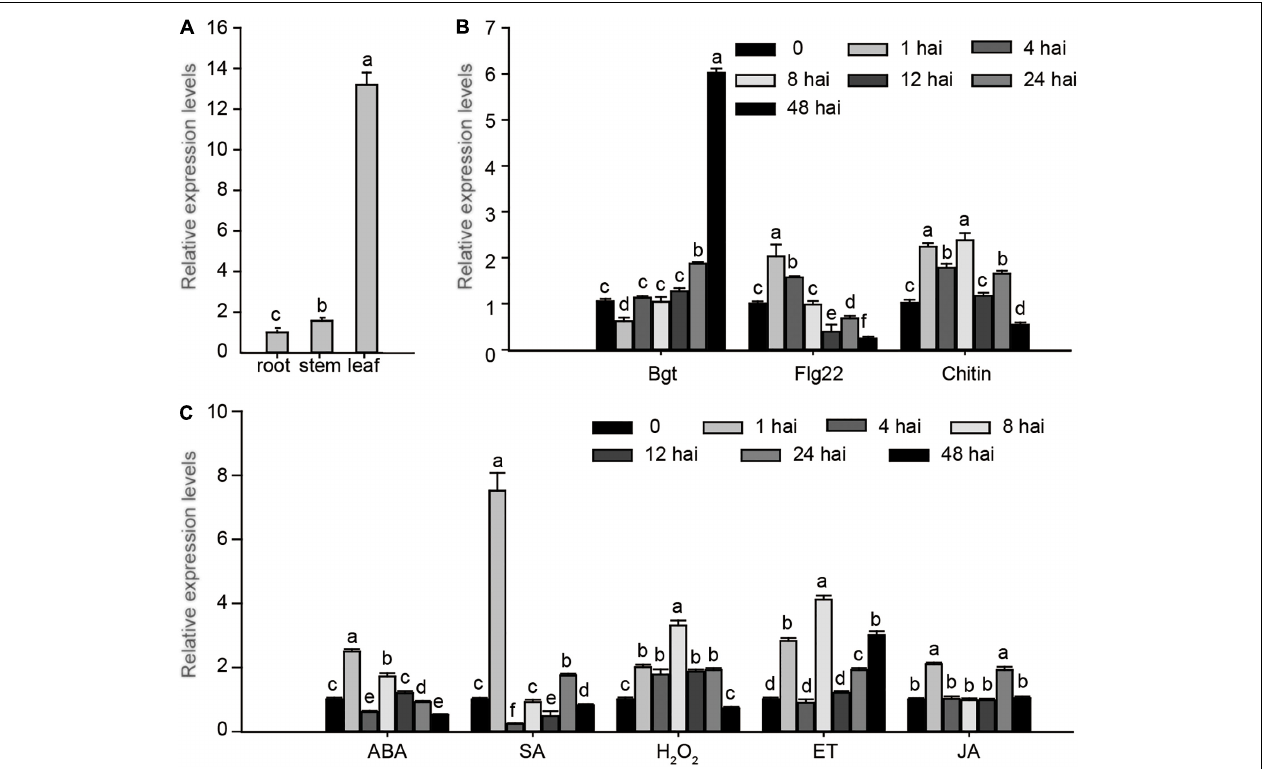
FIGURE 4 | Expression profiling of EXO70E1-V. (A) The expression of EXO70E1-V in root, stem, and leaf of H . villosa . (B) Expression levels of EXO70E1-V in biotic stresses of H. villosa . (C) Expression profiling of EXO70E1-V under stress-related signal treatments. Bgt, Blumeria graminis f.sp tritici ; SA, salicylic acid; MeJA, methyl jasmonate; ET, ethephon; ABA, abscisic acid; H 2 O 2 , hydrogen peroxide. Each column represents the means ± SD. Different lowercase letters represent significant differences at 5% level according to the least significant difference (LSD)